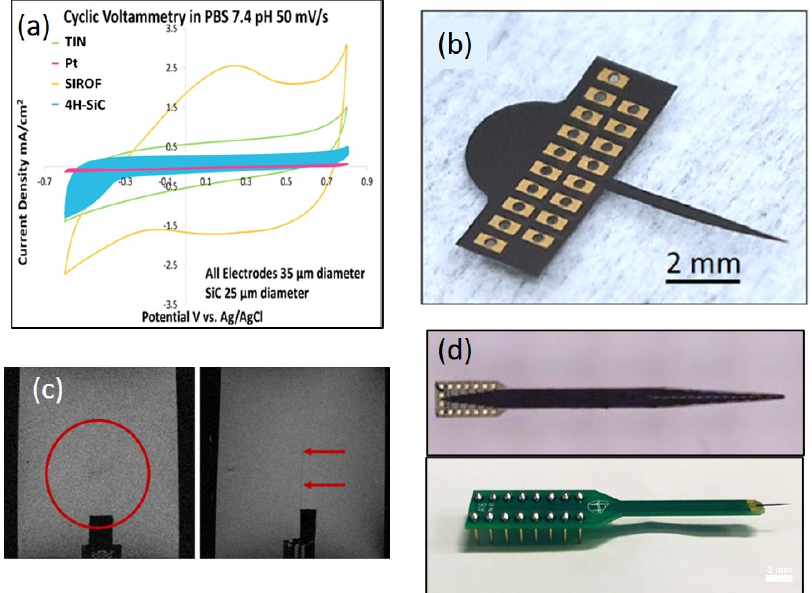
Figure 18. Examples of SiC INI devices developed in the USF SiC group. ( a ) CV performance comparison of an all-SiC (4H-SiC polytype) MEA showing superior performance to Pt electrodes of the same form-fit [51]. ( b ) Free-standing all-SiC (3C-SiC on SOI) 16-channel functional INI used to assess the MRI compatibility [54]. ( c ) Sagittal (left) and coronal (right) MRI images @7T showing no image artifacts and nearly transparent performance of 3C-SiC in a brain-tissue phantom. ( d ) Photographs of a released C-based a -SiC INI device ~1 µm thick (top) and a packaged device (bottom) with Si-backing for structural support mounted on a NeuroNexus package header for in vivo testing [53]. A comparison of both the all-SiC and C-based SiC electrodes has been complied by C. Feng and is shown in Table 1. Table 1. Electrochemical properties of SiC and common mINP electrode materials.